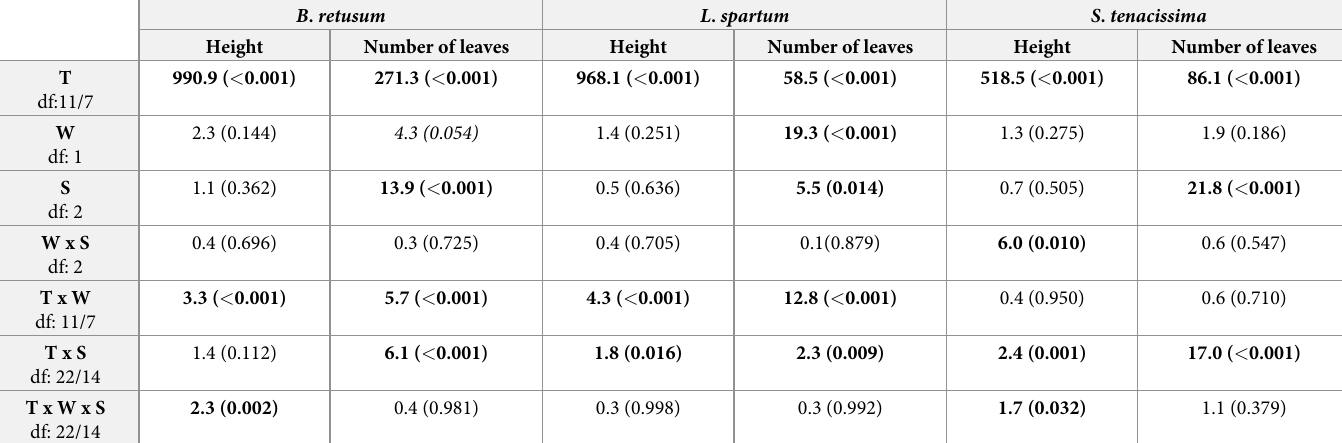
Table 1. Analysis of treatment effects on plant height and number of leaves for the three target